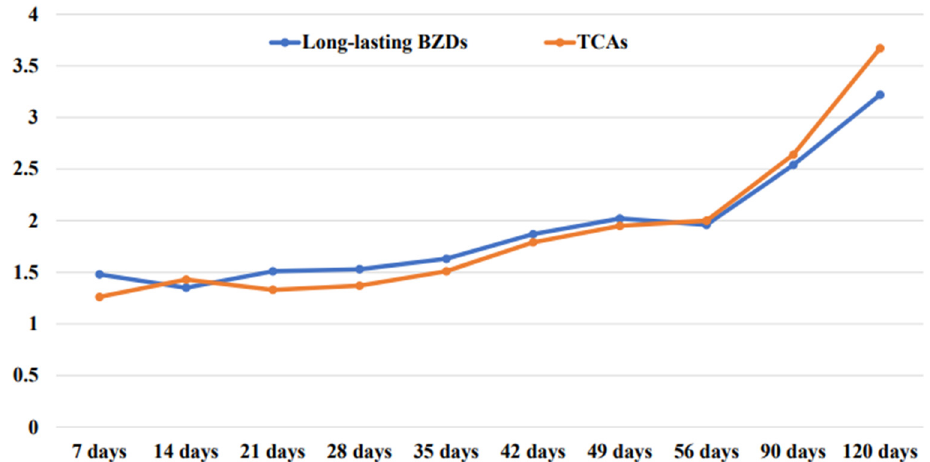
Figure 2. The relationship between the cumulative time of drug prescription and the increase in the risk of falls. risk of